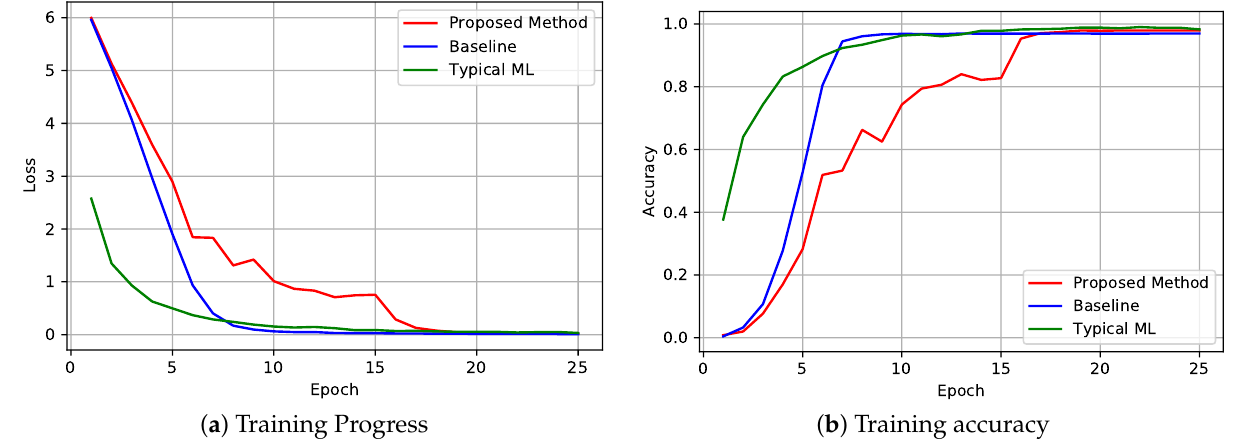
Figure 5. Federated Learning Outcomes in the proposed framework.